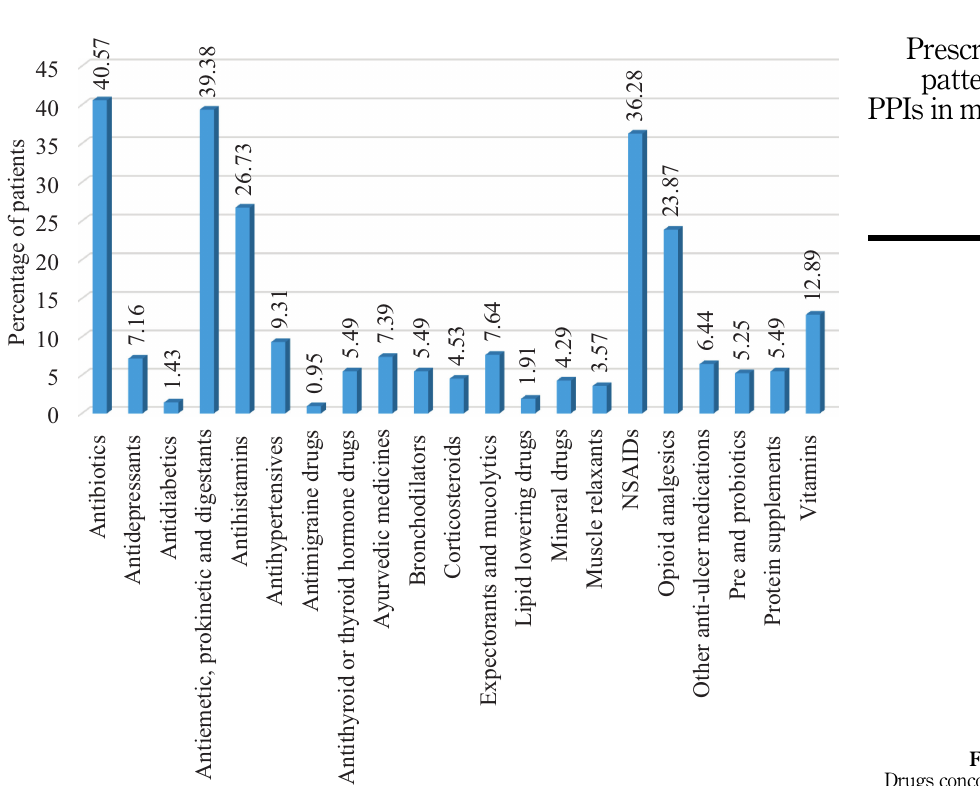
Figure 1. Drugs concomitantly prescribed with